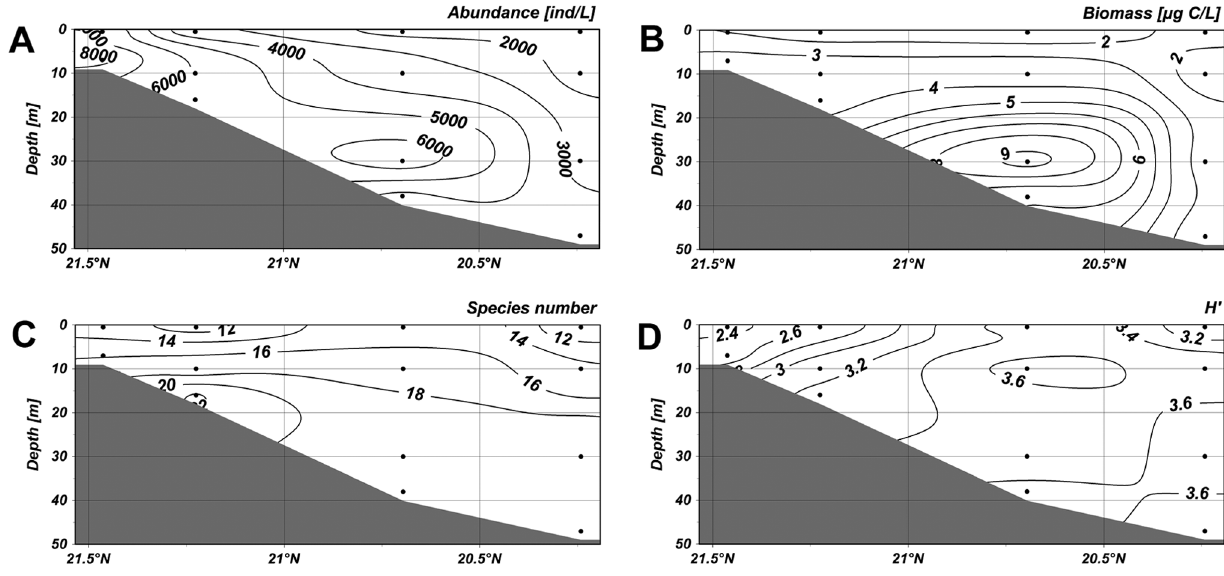
Figure 6. Vertical distribution of planktonic ciliates in the section 5–8. (A) Vertical distribution of abundance. (B) Vertical distribution of biomass. (C) Vertical distribution of species number. (D) Vertical distribution of diversity. The horizontal axis and vertical axis expressed the gradients in latitude and water depth, respectively. (TIFF).